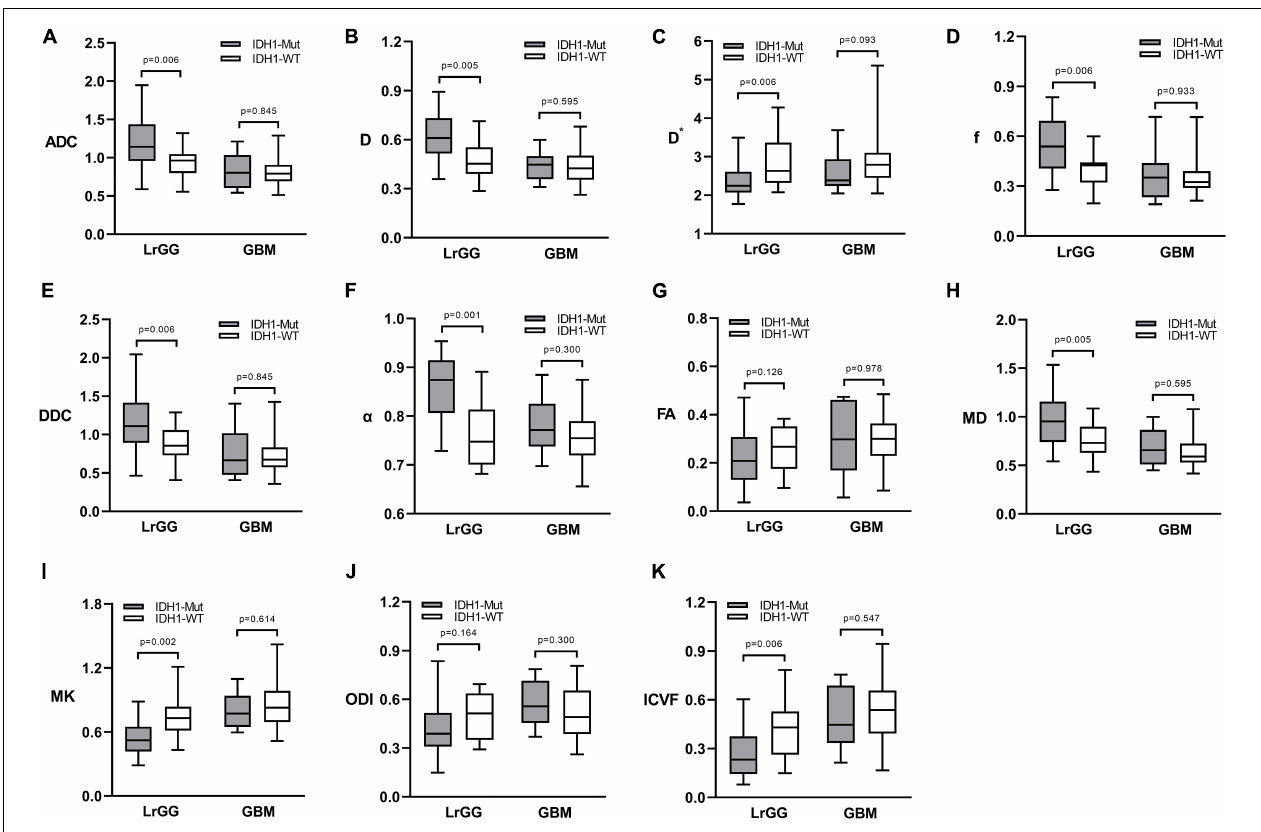
FIGURE 2 | Box and whisker plots of DWI (A) , IVIM (B–D) , stretched-exponential DWI (E,F) , DTI (G,H) , DKI (I) , and NODDI (J,K) parameter in LrGGs and GBMs stratified according to IDH1 genotype. Boxes represent the median ± quartiles, with whiskers extending to the maximum and minimum values. ADC, D, D*, and